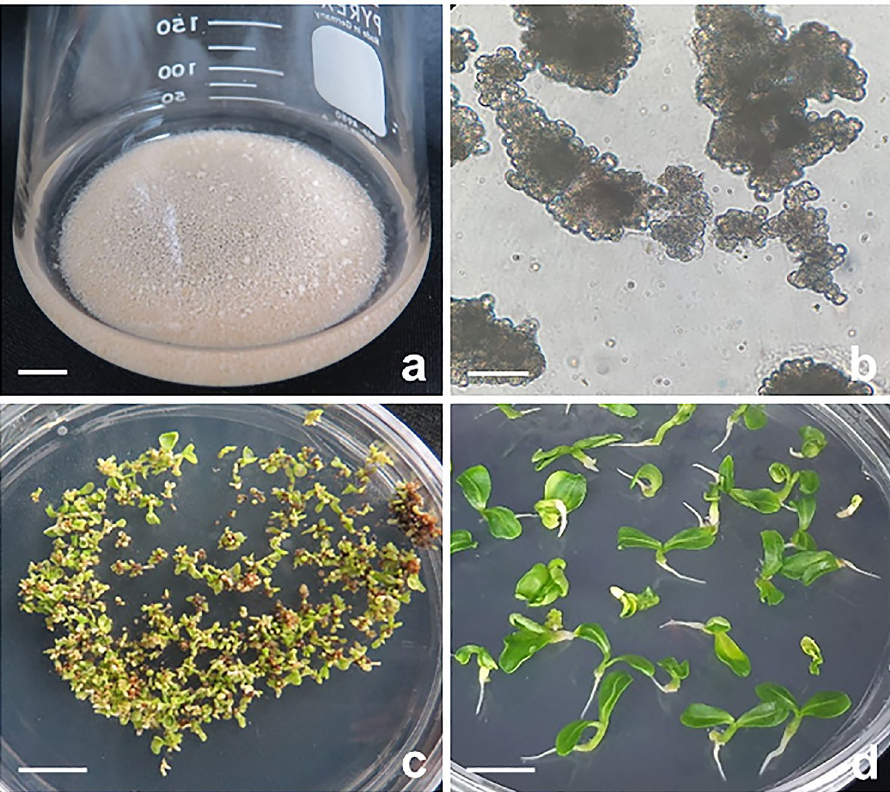
Figure 5. Establishment of plant regeneration system from embryogenic cell suspension cultures. ( a ) Embryogenic cell suspension cultures; ( b ) proliferation of embryogenic cell aggregates; ( c ) development of numerous somatic embryos from cell suspension cultures; ( d ) conversion of somatic embryos into plantlets. Scale bars represent 1 cm ( a , c , d ), and 200 µm ( b ),